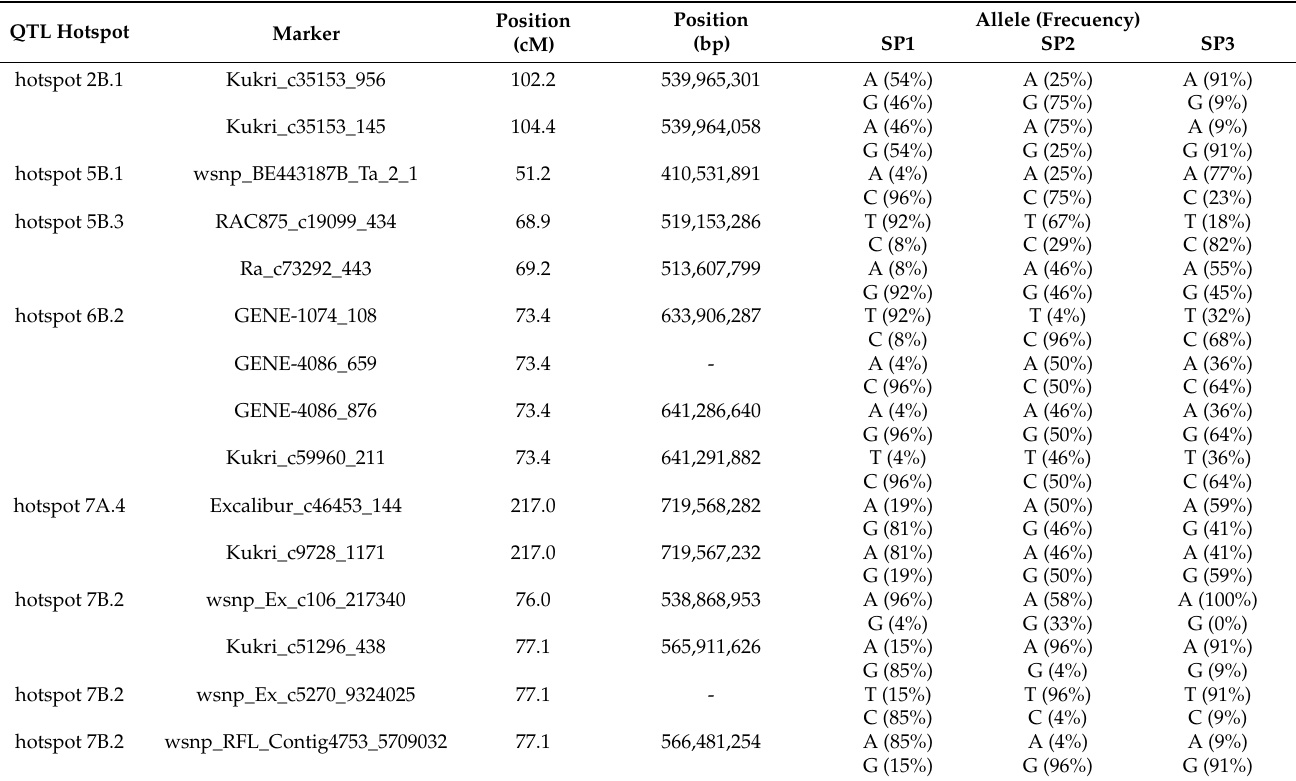
Table 4. QTL hotspots involved in the differentiation patterns showing allelic differences among